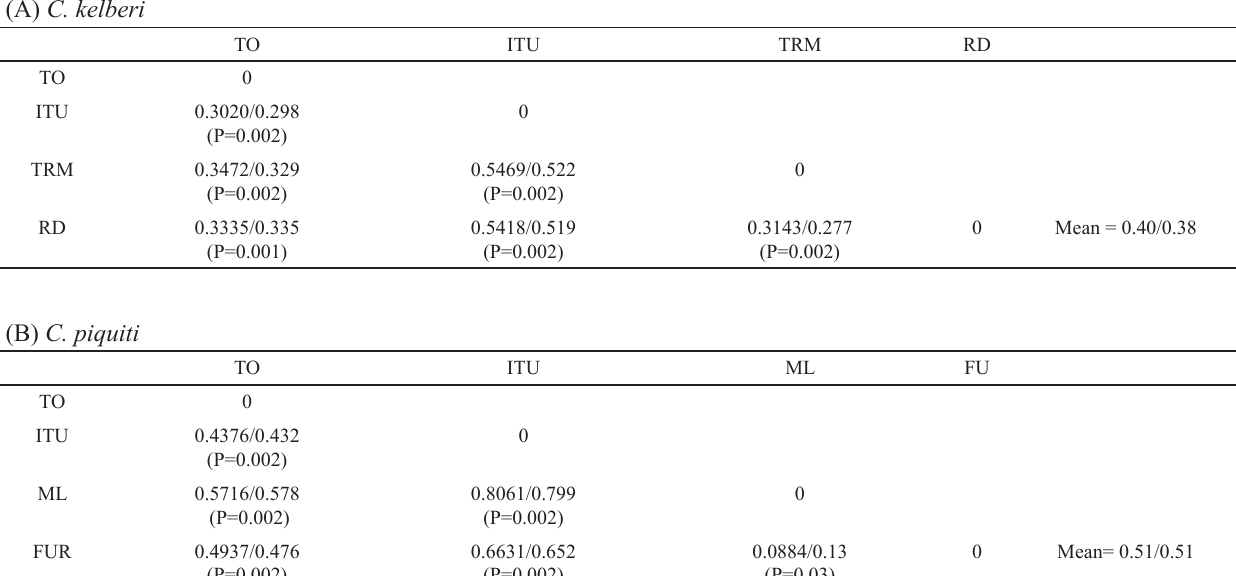
Table 2. Pairwise Fixation Index for native and invasive populations of C. kelberi (A) and C. piquiti (B). The first value is the estimate F of Weir (1996) and the second is the F STENA using ENA correction (Chapuis & Estoup, ST